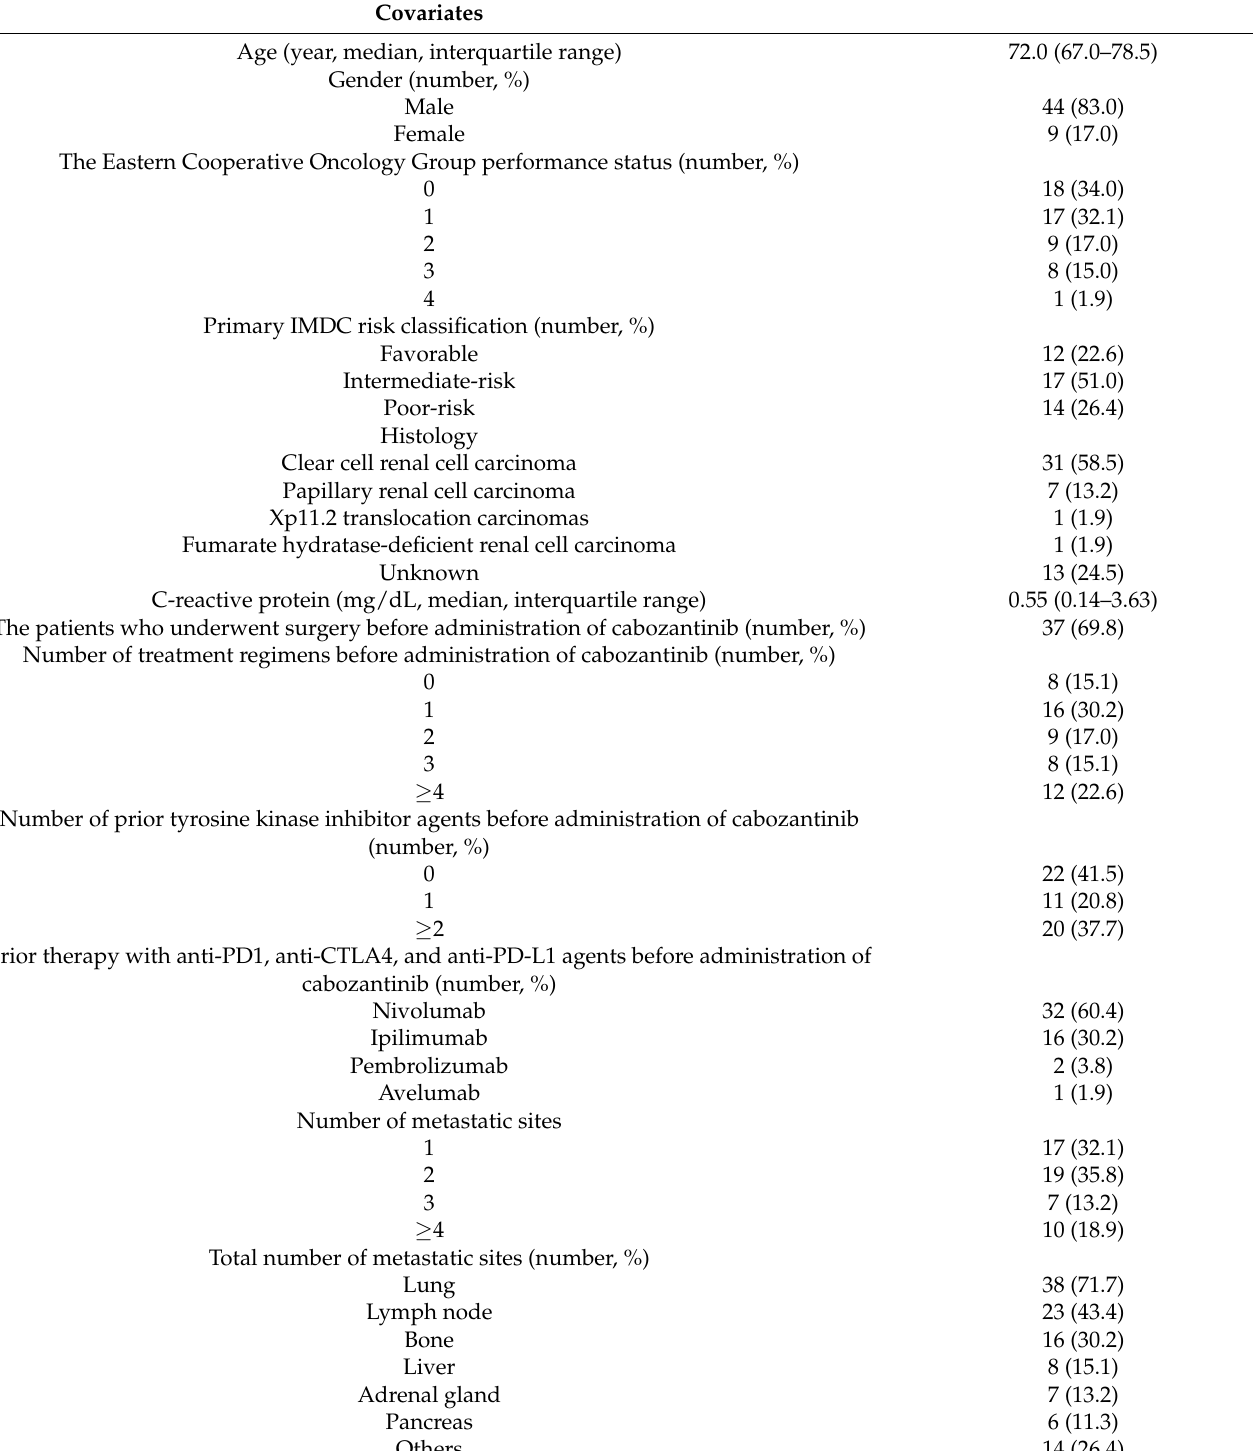
Table 1. Patient characteristics at the start of cabozantinib